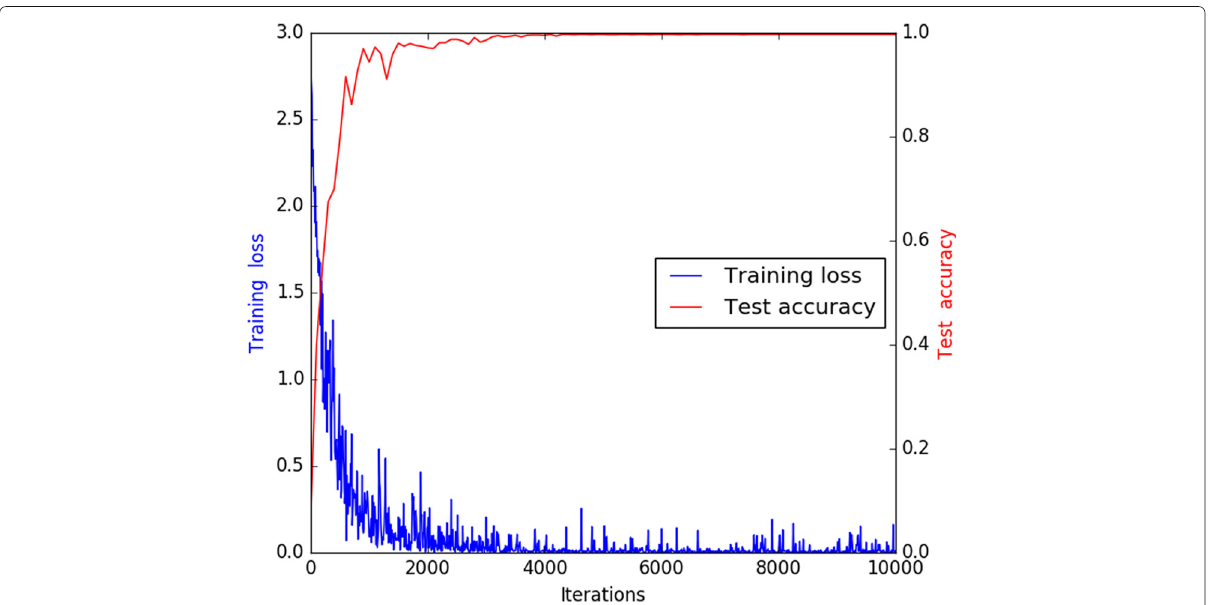
Fig. 8 The experimental result of our proposed CNN architecture